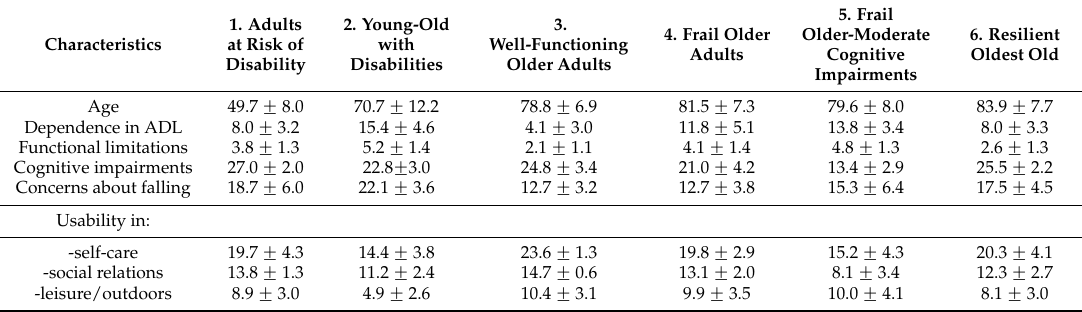
Table 2. Characteristics of the six clusters identified (mean ˘ SD).